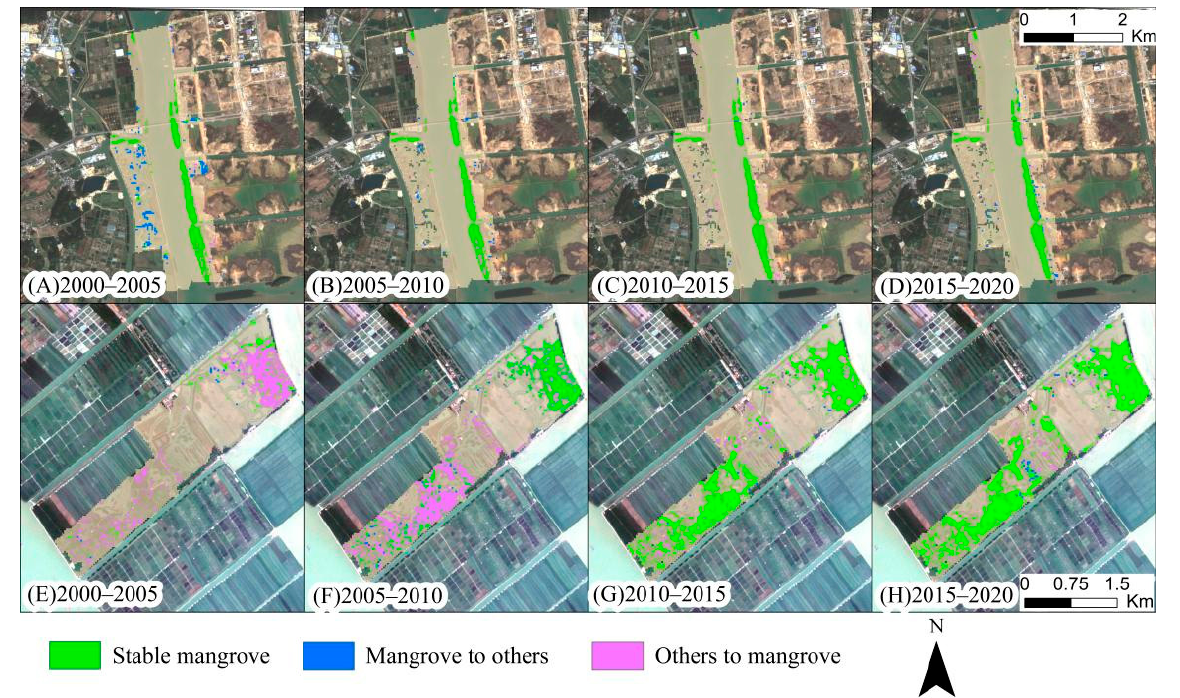
Figure A5. Mangrove gain and loss in GZCNWP ( A – D ) and NWP ( E – H ) every five years from 2000 to 2020. ( A , E ): 2000–2005, ( B , F ): 2005–2010, ( C , G ): 2010–2015, ( D , H ): 2015–2020.